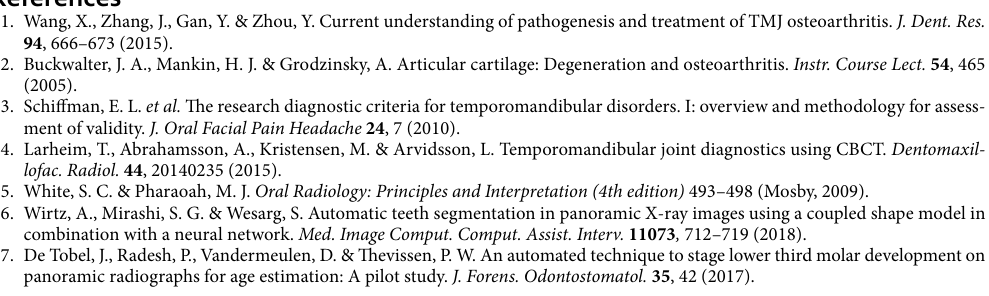
model. The test set consisted of 150 normal, 150 indeterminate, and 150 OA images (Fig. 3). Data augmentation was done by image rotation ± 5 degrees, image shift ± 10%, brightness ± 10%, and contrast ± 10% to compensate for the disadvantage of the small number of the data points to increase model robustness. Training and valida- tion were repeated 35,000 times (700 epochs) with augmented data. The learning rate of the model was 1.0 × 10 –6 and an Adam optimizer was used. After 700 training epochs, the validation loss of the model decreased from 12.2 to 0.1. In order to find the most suitable model for screening TMJOA, Indeterminate OA was treated as follows during AI model development.